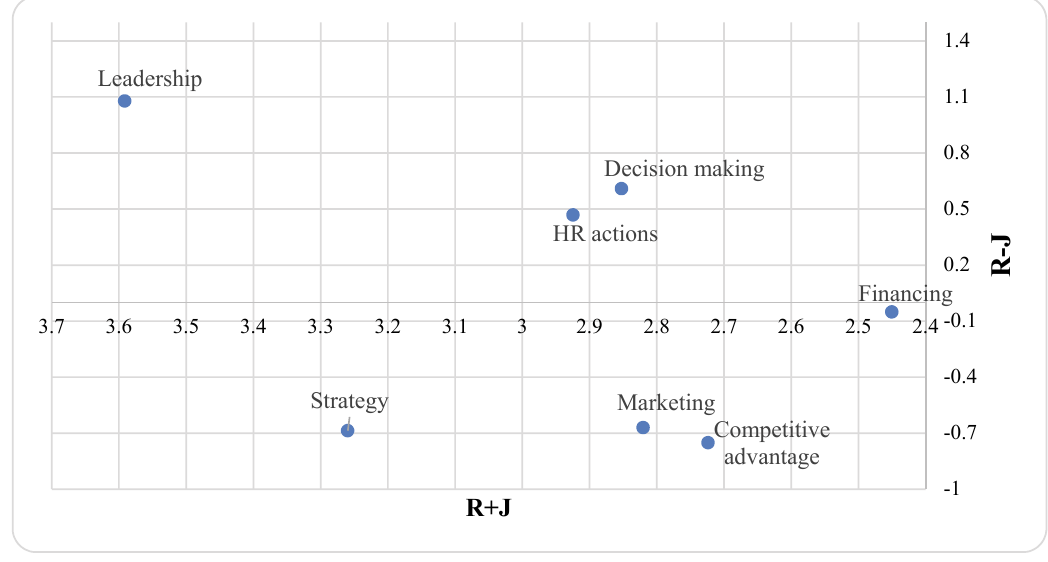
Fig. 3. Effectiveness chart of effective